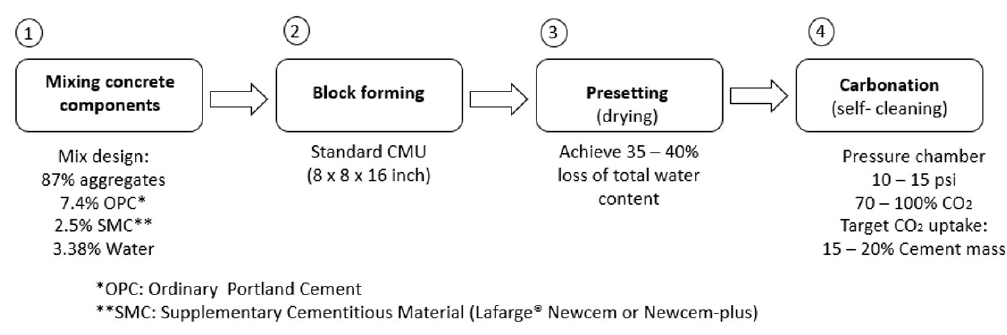
Figure 6. Manufacturing and curing process. Source: [35].